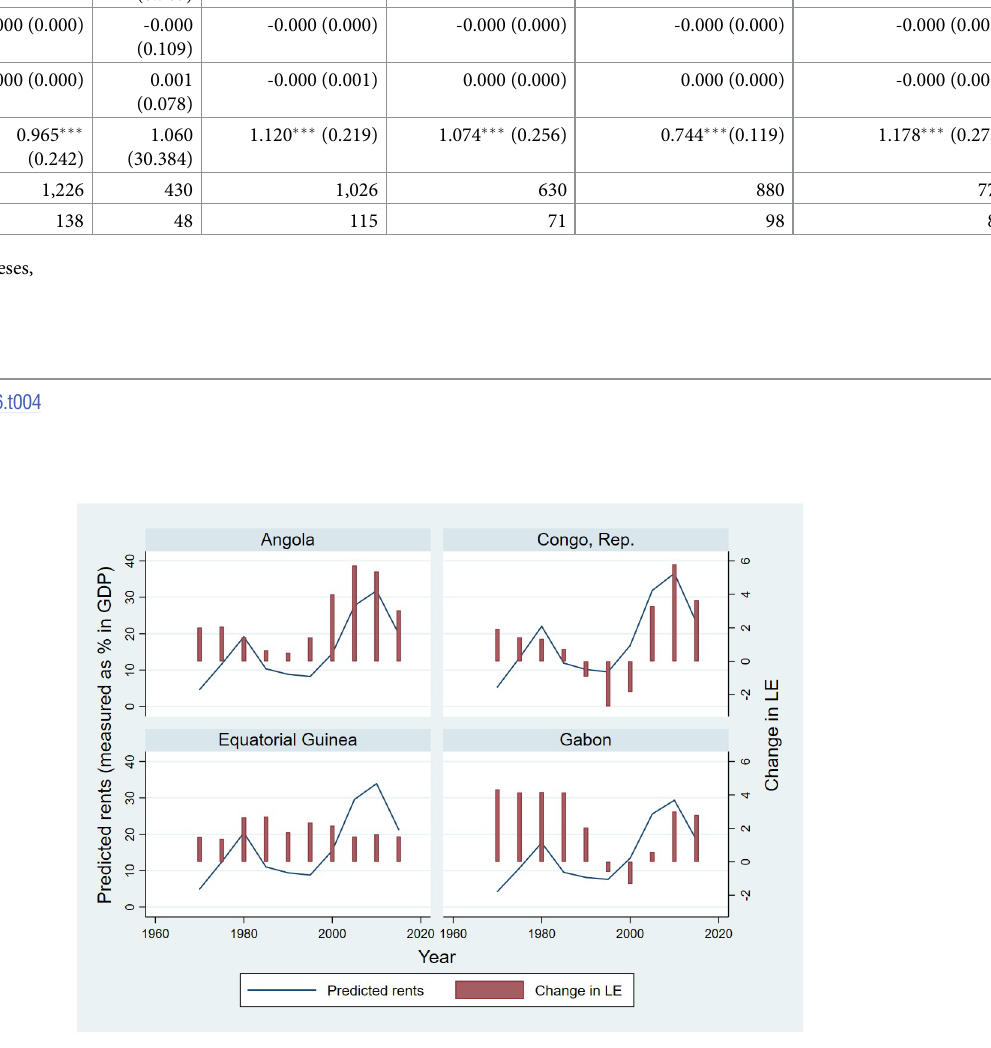
Fig 2. Relationship between predicted rents and change in life expectancy in five-year intervals. Data source: World Development Indicators (WDI).